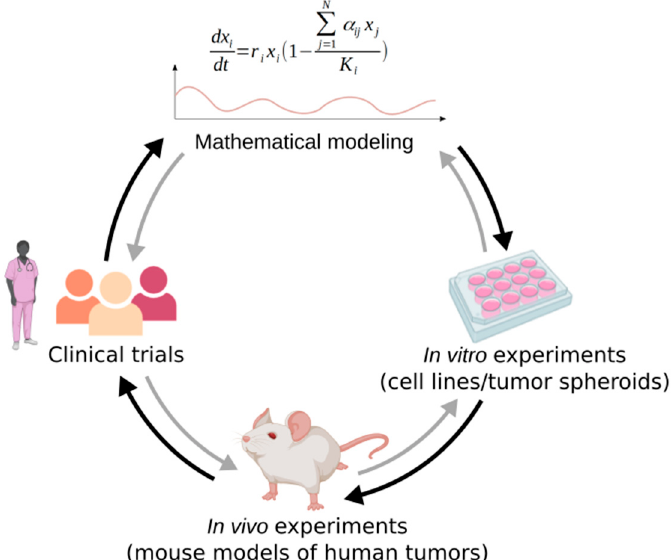
Figure 2. Mathematical modeling integration in clinical investigation. Mathematical models can be used to design in vitro and in vivo experiments, and clinical trials. Conversely, the retrospective analysis of experiments and clinical trials can help improve models, understand the dynamics they predict, and define the values of their parameters. Adapted from [25], created with BioRender.